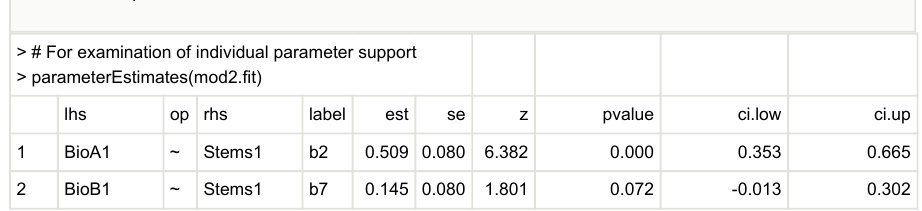
Parameter-specific statistics for Model